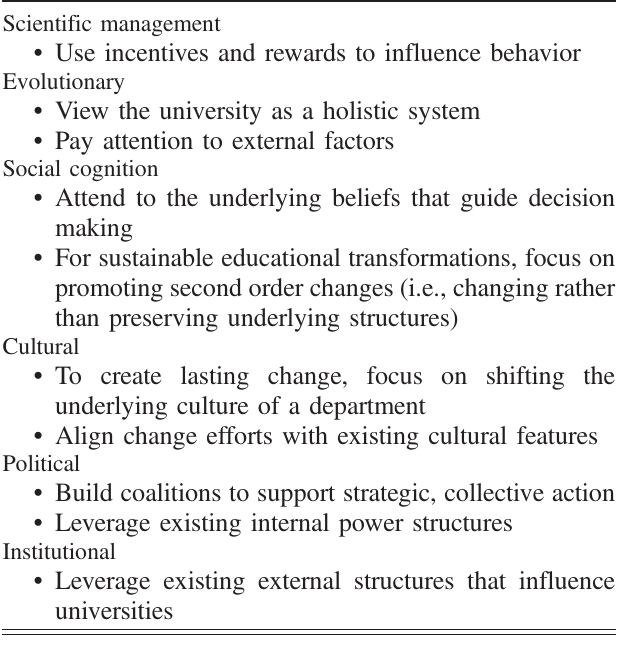
TABLE II. Key insights from six change